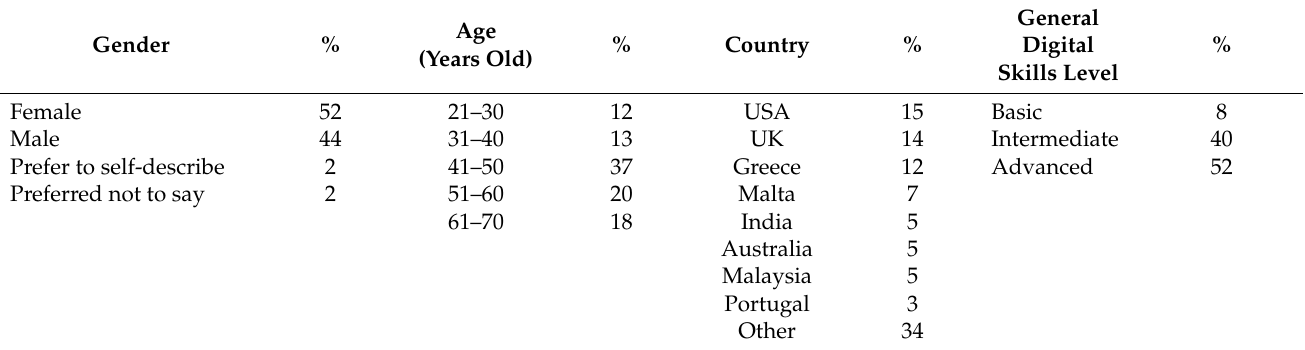
Table 1. Participants’ socio-demographic characteristics ( N = 93).